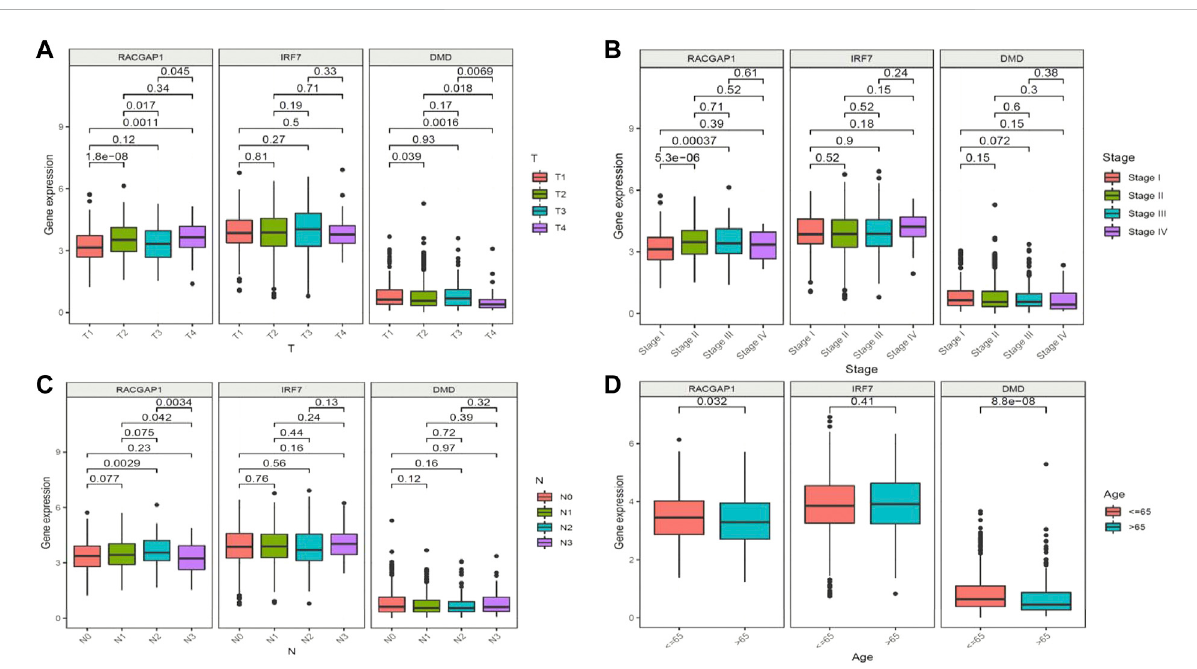
FIGURE 5 Clinical prognostic model and gene correlation analysis. (A) Association of the expression of RACGAP1 , IRF7 , and DMD with tumor stage and metastasis in patients with breast cancer (BRCA). (B) Association of the expression of RACGAP1 , IRF7 , and DMD with the number of lymph node metastases. (C) Associationoftheexpressionof RACGAP1 withBRCAstaging. (D) Associationoftheexpressionof RACGAP1 , IRF7 ,and DMD